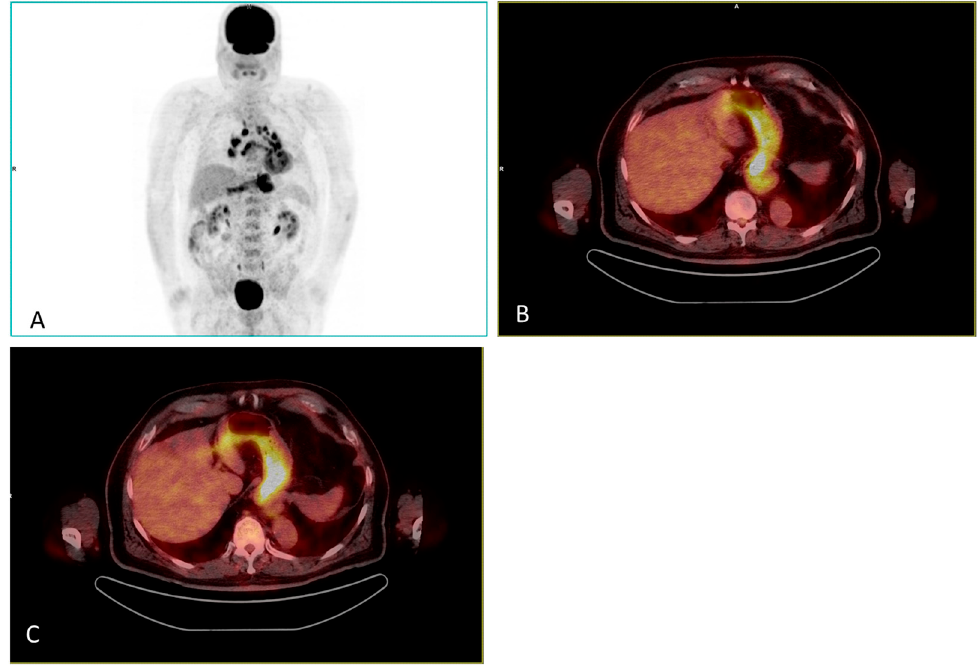
Figure 4. 73-year-old man with dorsal melanoma under treatment with Nivolumab and granuloma- tous reaction sarcoid-like as well as acute gastritis. [ 18 F]FDG PET/CT MIP ( A ) and axial fusion slices ( B , C ) are presented. Treatment was